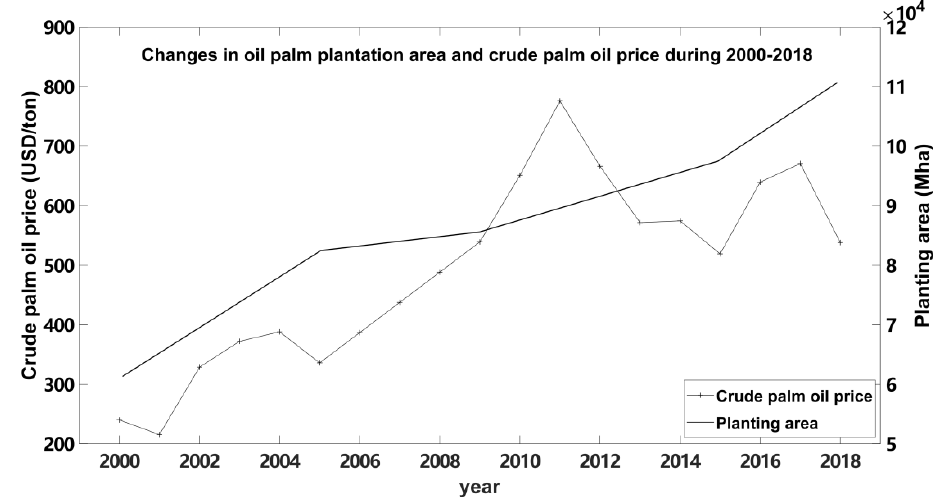
Figure 10. The changes in oil palm planting area and the price of crude palm oil.